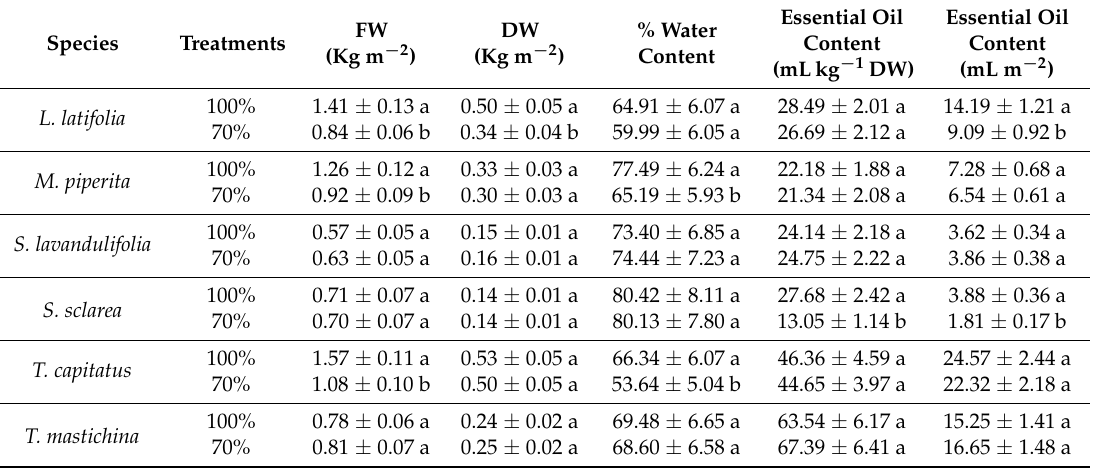
Table 4. Fresh weight and dry weight, water content, and essential oil content in the species studied under different drought